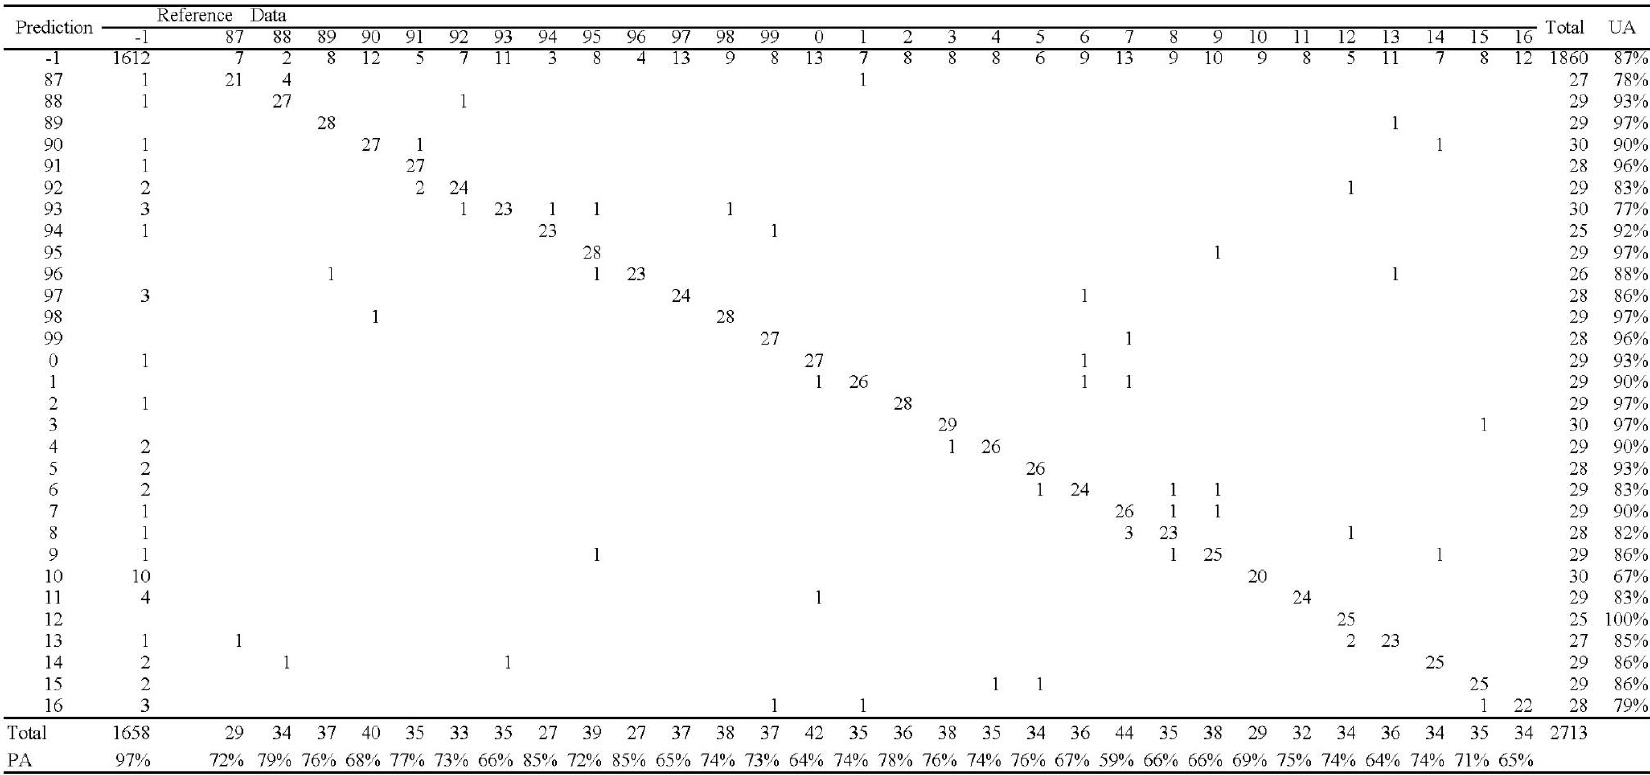
Figure A1. Count-based confusion matrix. Reference data and prediction class values represent the last disturbance year (e.g., 89 = year 1989). The − 1 class represents the undisturbed class. UA = user’s accuracy. PA = producer’s accuracy.